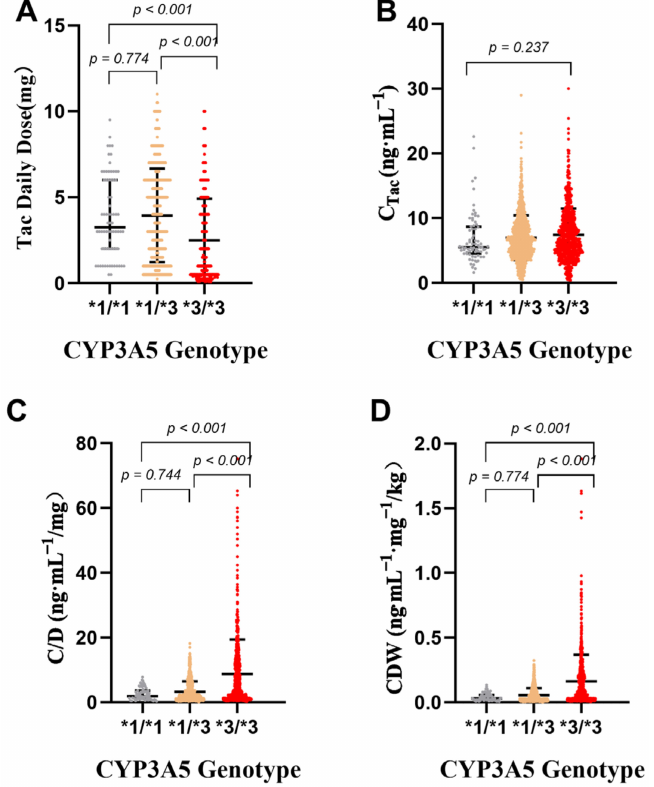
Figure 5. Effects of CYP3A5 genotypes on tacrolimus daily dose ( A ), C Tac ( B ), C/D ( C ), and CDW ( D ). p value was tested by Kruskal–Wallis test and adjusted by Dunn–Bonferroni correction;